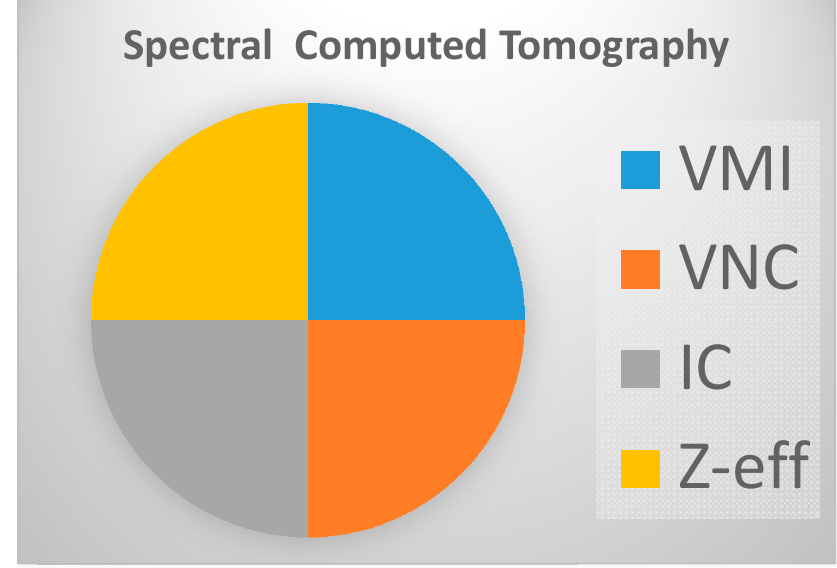
Figure 1. Imaging possibilities in Dual Energy Computed Tomography (DECT). VMI—virtual monochromatic images; VNC—virtual non contrast; IC—iodine concentration; Z-eff—analysis based on effective atomic number.